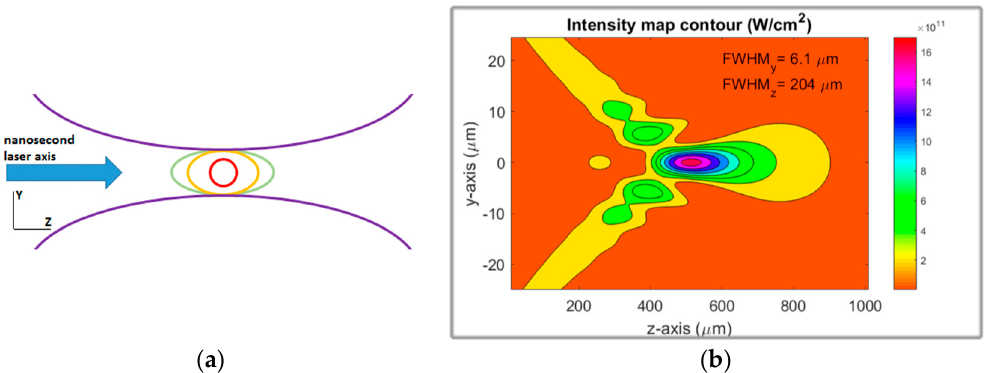
Figure 4. (a) Conceptual sketch of laser intensity distribution desired for an optimal laser wake field electron-acceleration (LWFA) in the transverse plane with respect to the nanosecond laser axis (or “z-axis”) in the focal region. The colored lines represent constant intensity zones. Red indicates maximum, orange medium and green low intensities; (b) y-z plane numerical simulation of the laser intensity distribution in W/cm 2 by the combination of a 200-mm plano-convex and a 100-mm cylindrical lens (a strong asymmetry is shown).